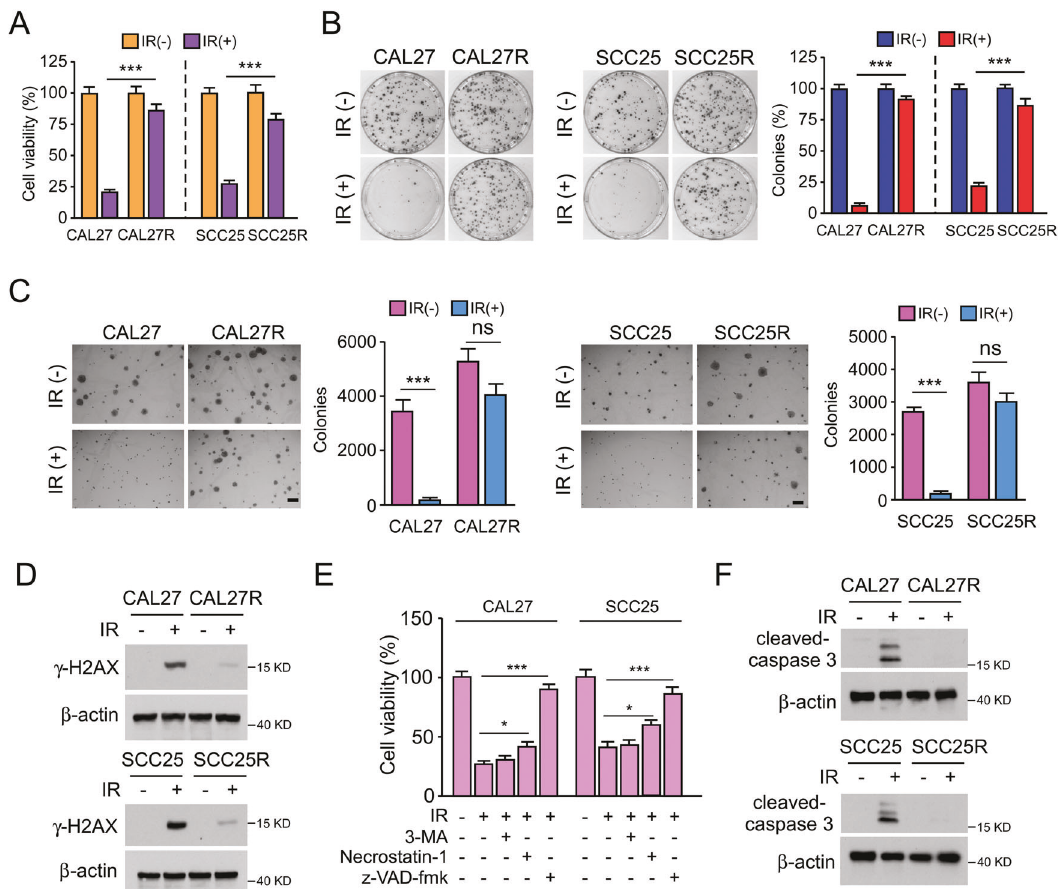
Fig. 1 Irradiation induces apoptosis in OSCC cells. A MTS assay was used to determine the cell viability of CAL27/CAL27R and SCC25/SCC25R cells treated with/without IR (2 Gy) for 72 h. B Plate colony formation assay was performed to analyze the colony formation of CAL27/CAL27R and SCC25/SCC25R cells treated with/without IR (2 Gy) for 72 h. C Soft agar assay was employed to assess the anchorage-independent cell proliferation of CAL27/CAL27R and SCC25/SCC25R cells treated with/without IR (2 Gy) for 72 h. D Immunoblotting for γ -H2AX expression in CAL27/CAL27R and SCC25/SCC25R cells treated with/without IR (2 Gy) for 72 h. E z-VAD-fmk rescued IR-reduced cell viability. CAL27 and SCC25 cells were pretreated with z-VAD-fmk, Necrostatin-1, or 3-MA for 4 h, followed by IR (2 Gy) treatment for 72 h. F CAL27/CAL27R and SCC25/SCC25R cells were treated with/without IR (2 Gy) for 72 h. The cell lysates were prepared with the IP buffer. Cleaved-caspase 3 expression was determined by immunoblotting. All data are means ± s.e.m. * p < 0.05, *** p < 0.001, ns not statistically signi fi cant. a signi fi cant difference between groups as